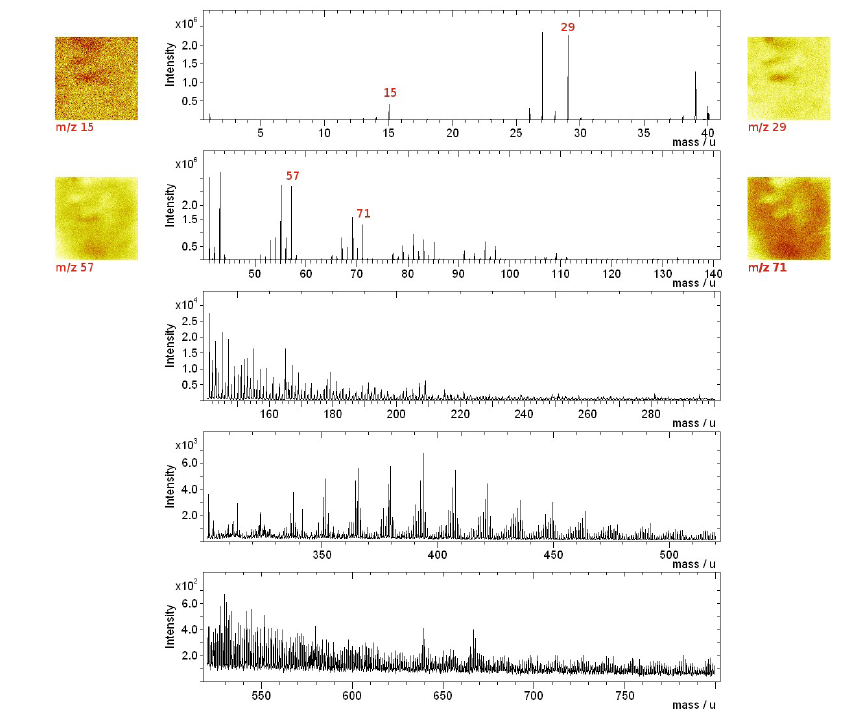
Figure 5. SIMS spectra of mercaptoacetic acid SAM onto the Ag functionalisated with L-Tryptophan in positive mode.